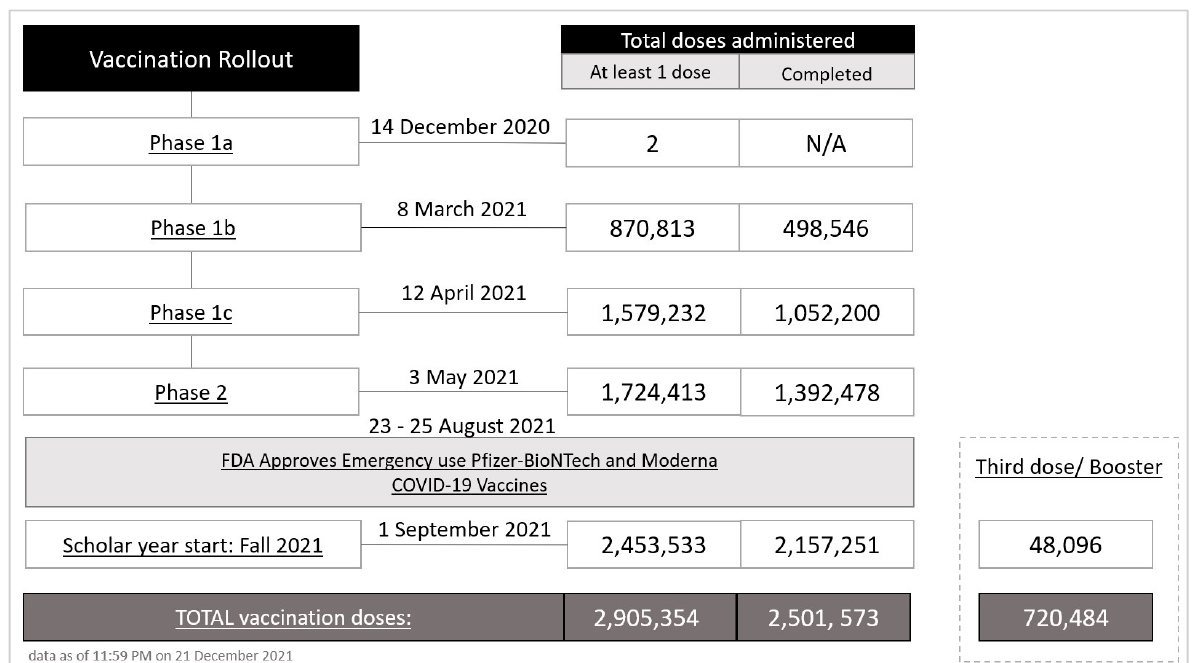
Figure 1. Vaccination rollout dates, corresponding pandemic phase, and the total number of doses administered including Pfizer-BioNTech and Moderna (first or completed doses), and J&J/Janssen (as complete dose): South Carolina, December 2020–December 2021. The information was obtained from the SC DHEC COVID-19 vaccine guidance and allocations data [14] and the Vaccination Dashboard